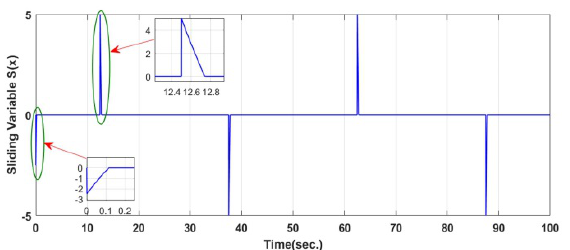
Figure 5. Desired speed 3 d x (cid:5) and load speed ( 4 l x θ= time for the two-mass system connected by a gearbox